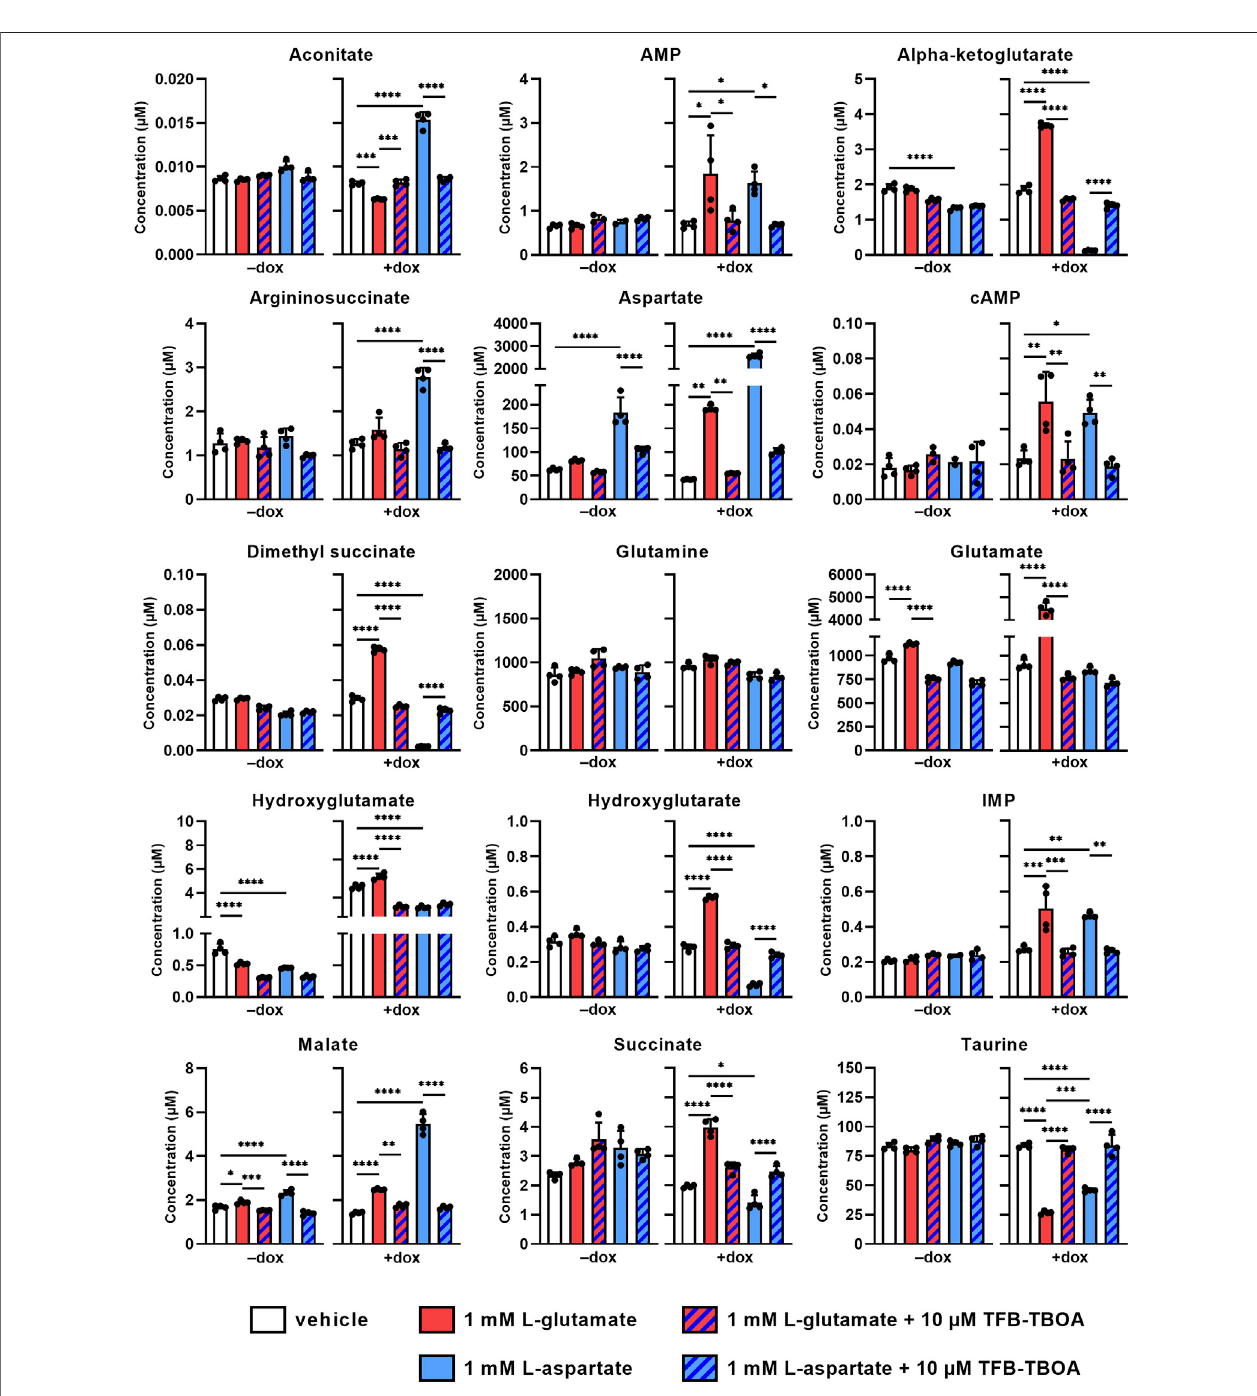
FIGURE 4 | Changes in intracellular metabolite levels upon substrate stimulation of JumpIn-EAAT1 cells. Targeted metabolomics was used to measure the concentrations of several metabolites in the absence ( − dox) or presence (+dox) of doxycycline. AMP, adenosine monophosphate; cAMP, cyclic AMP; IMP, inosine monophosphate. Cells were pretreated for 1 h with vehicle (PBS/DMSO, plain bars) or 10 µM TFB-TBOA (hatched bars) prior to stimulation with vehicle (PBS, white bars),1 mML-glutamate(redbars)orL-aspartate(bluebars).Dataareshownasthemeanconcentration(inµM)±SDoffourreplicateexperiments.* p < 0.05,** p < 0.01, *** p < 0.001, **** p < 0.0001; one-way ANOVA with Tukey ’ s post-hoc test.